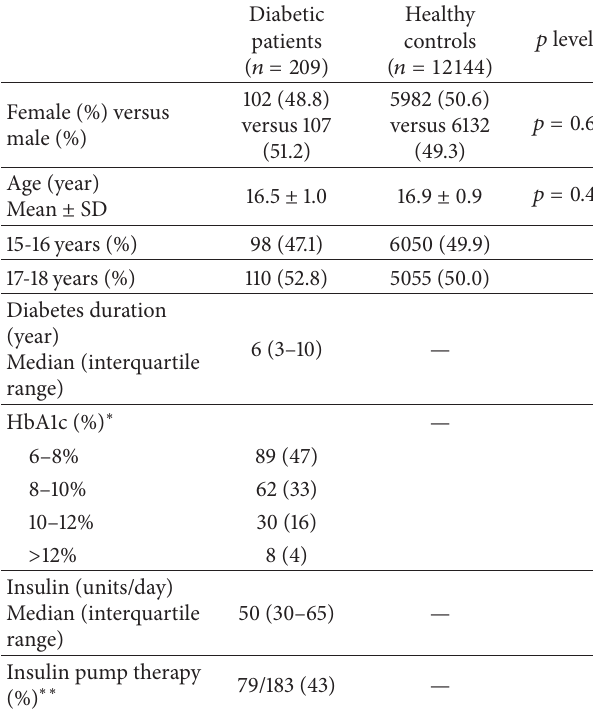
Table 1: Clinical characteristics of patients with diabetes and controls.